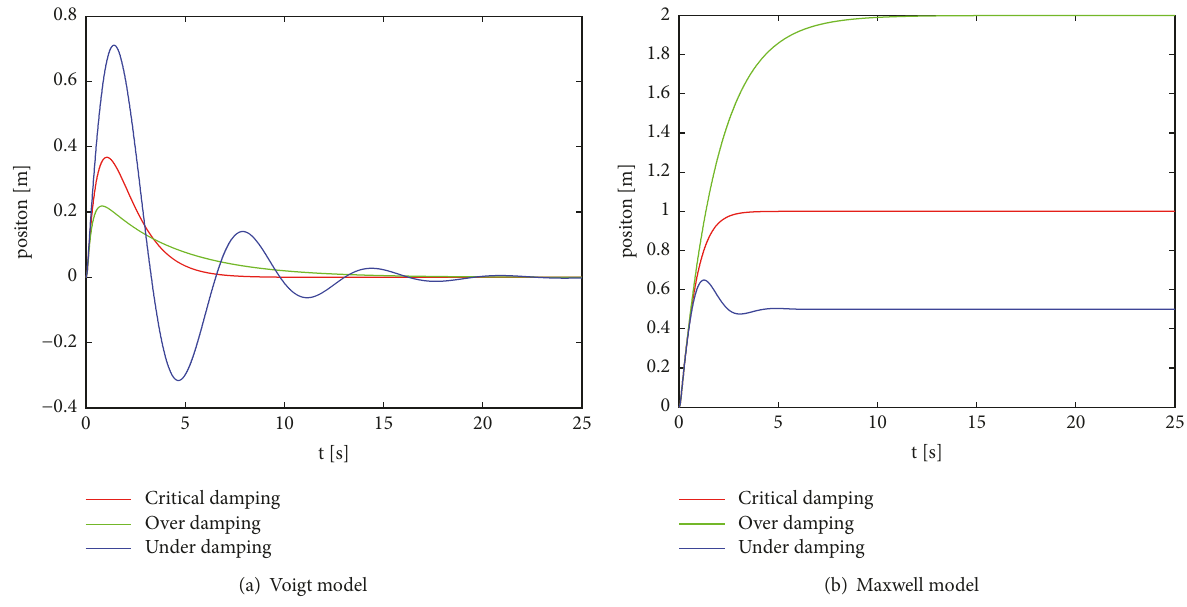
Figure 1: Dynamic properties depending on different coefficients of two viscoelastic models in one-dimensional